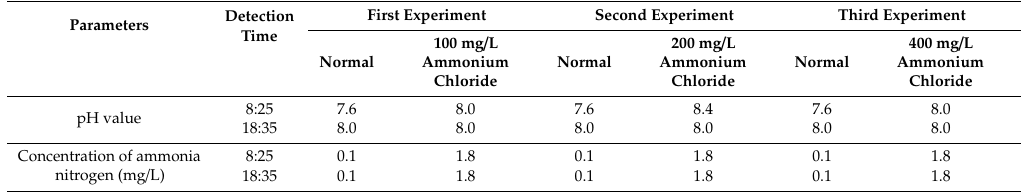
Table 2. Concentration of ammonium chloride and pH value of water under di ff erent